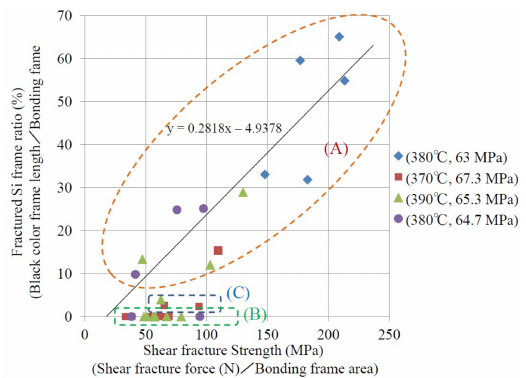
Figure 9. Relationship between fractured Si frame ratio and shear fractured strength. Fractured Si frame ratio (%) is defined as black Si fracture length divided by bonding frame length. The linear approximation formula of region (A), and the bonding temperature and pressure are also